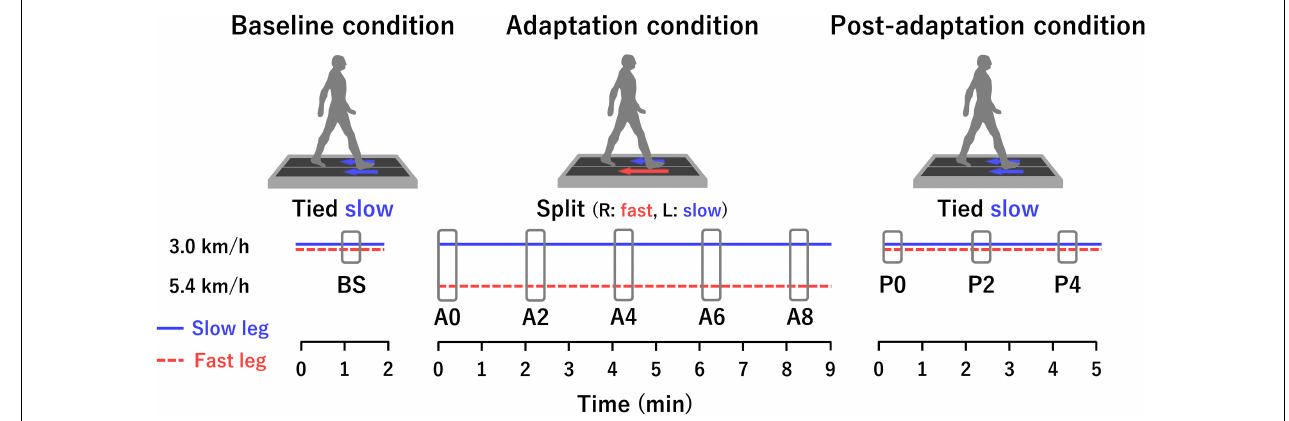
FIGURE 1 | Experimental paradigm and analysis sections. Tied is a belt condition in which both belts move at the same speed. Split is a belt condition in which each belt moves at a different speed. In the adaptation condition, the right belt was fast (5.4 km/h), and the left belt was slow (3.0 km/h) for all participants. The horizontal blue solid and red dotted lines represent the slow leg and fast leg, respectively. The horizontal axis indicates time. Each rectangle in the baseline, adaptation, and post-adaptation conditions represents the analysis sections consisting of 20 gait cycles.